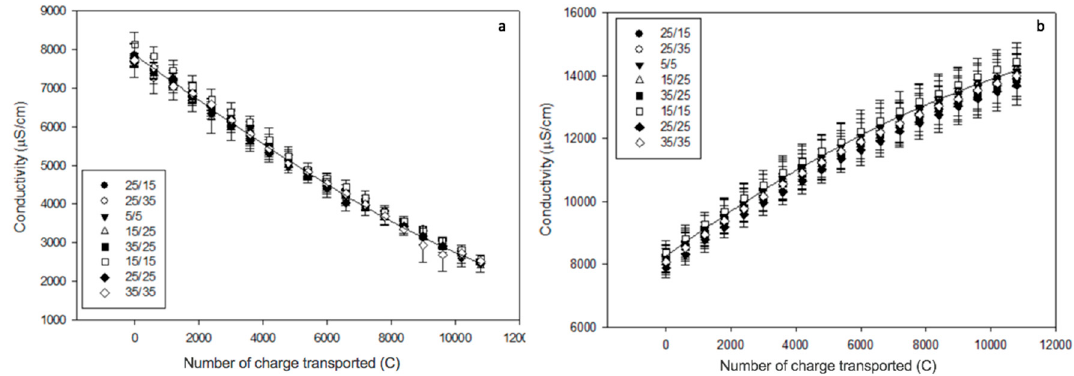
Figure 6. Conductivity evolution ( a ) in the AWComp and ( b ) OAComp for the eight PEF conditions tested.